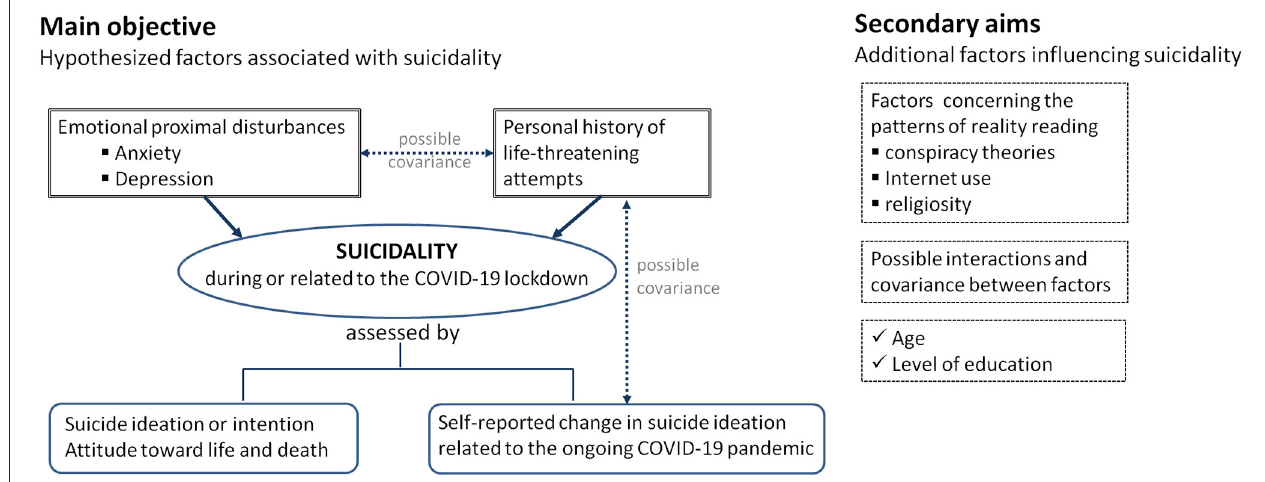
FIGURE 1 | Main objective and secondary aims of this national level analysis of data collected on Romanian adult participants in the cross-sectional international COMET-G study.